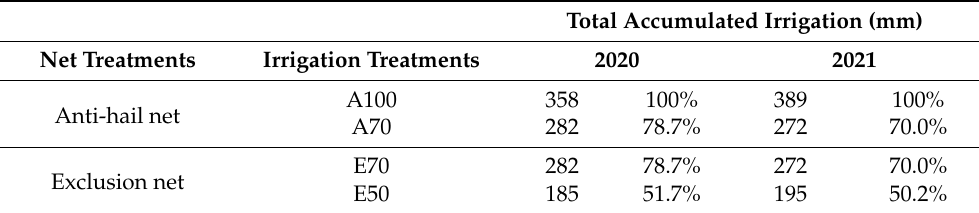
Total Accumulated Irrigation (mm)